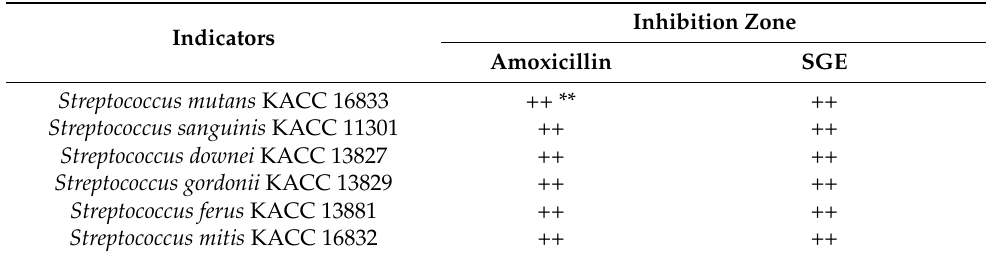
Table 1. Antimicrobial activity of SGE against oral Streptococci . Indicators